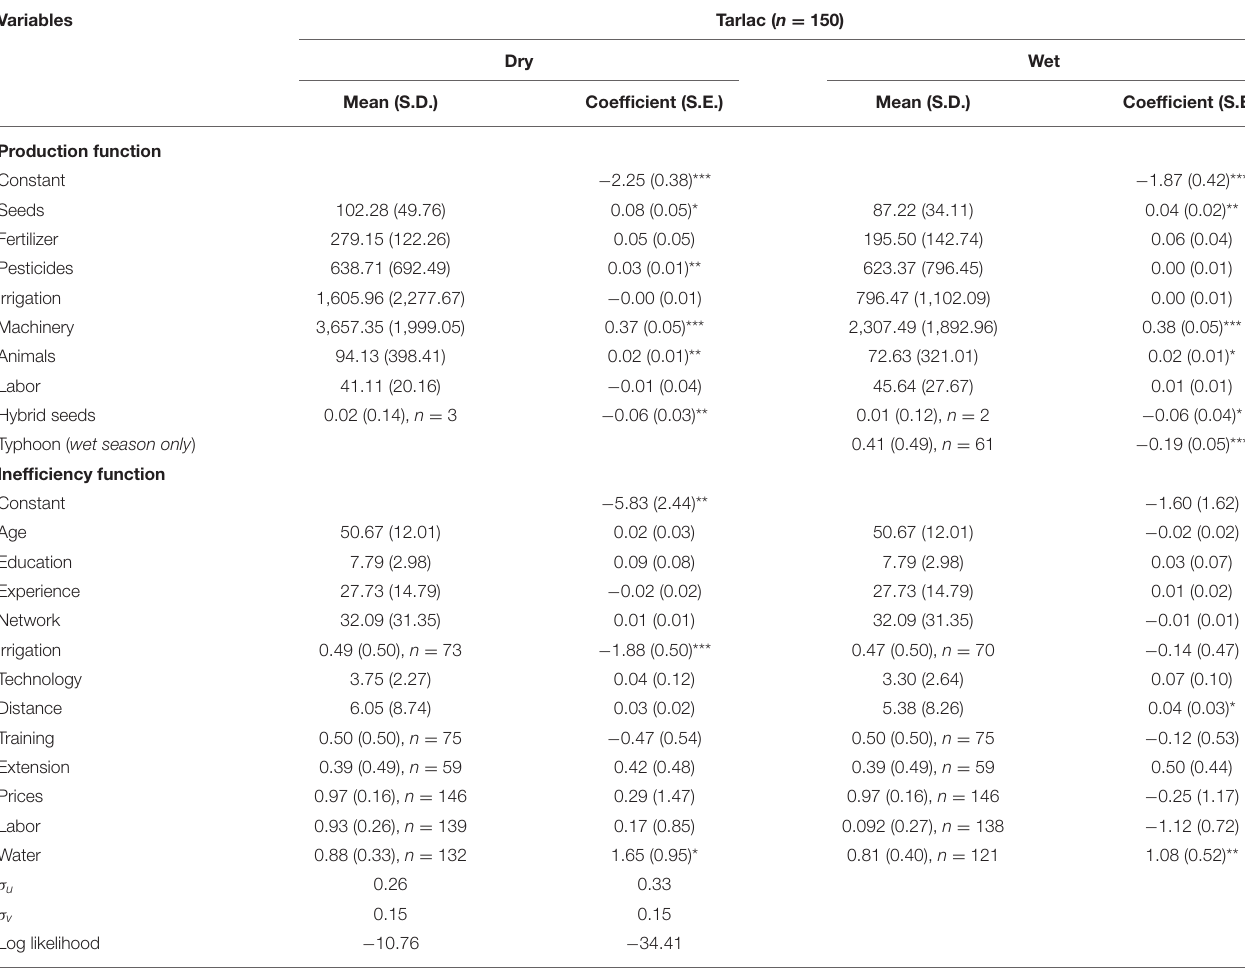
Tabulated data are from the author’s own calculation. The respective coefficients and the standard errors of the coefficients are correct to two significant digits. * Significant at 10%. ** Significant at 5%. *** Significant at